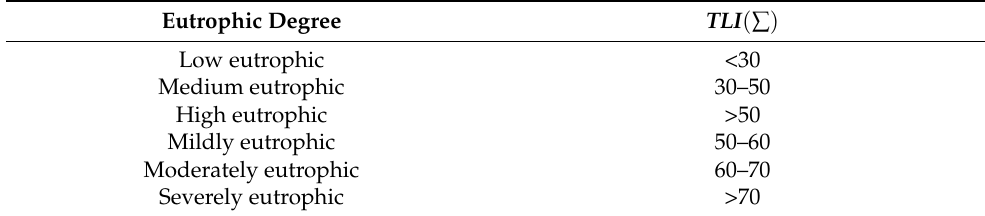
Table 5. Classification standards of eutrophic